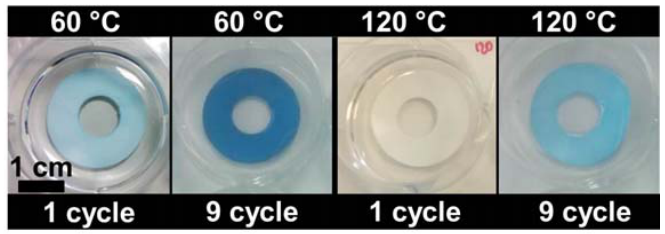
Figure 6. Photographic images of the membranes with TiO 2 nanoparticles (0.25 M HCl, 120 ◦ C or 60 ◦ C) after one cycle and nine